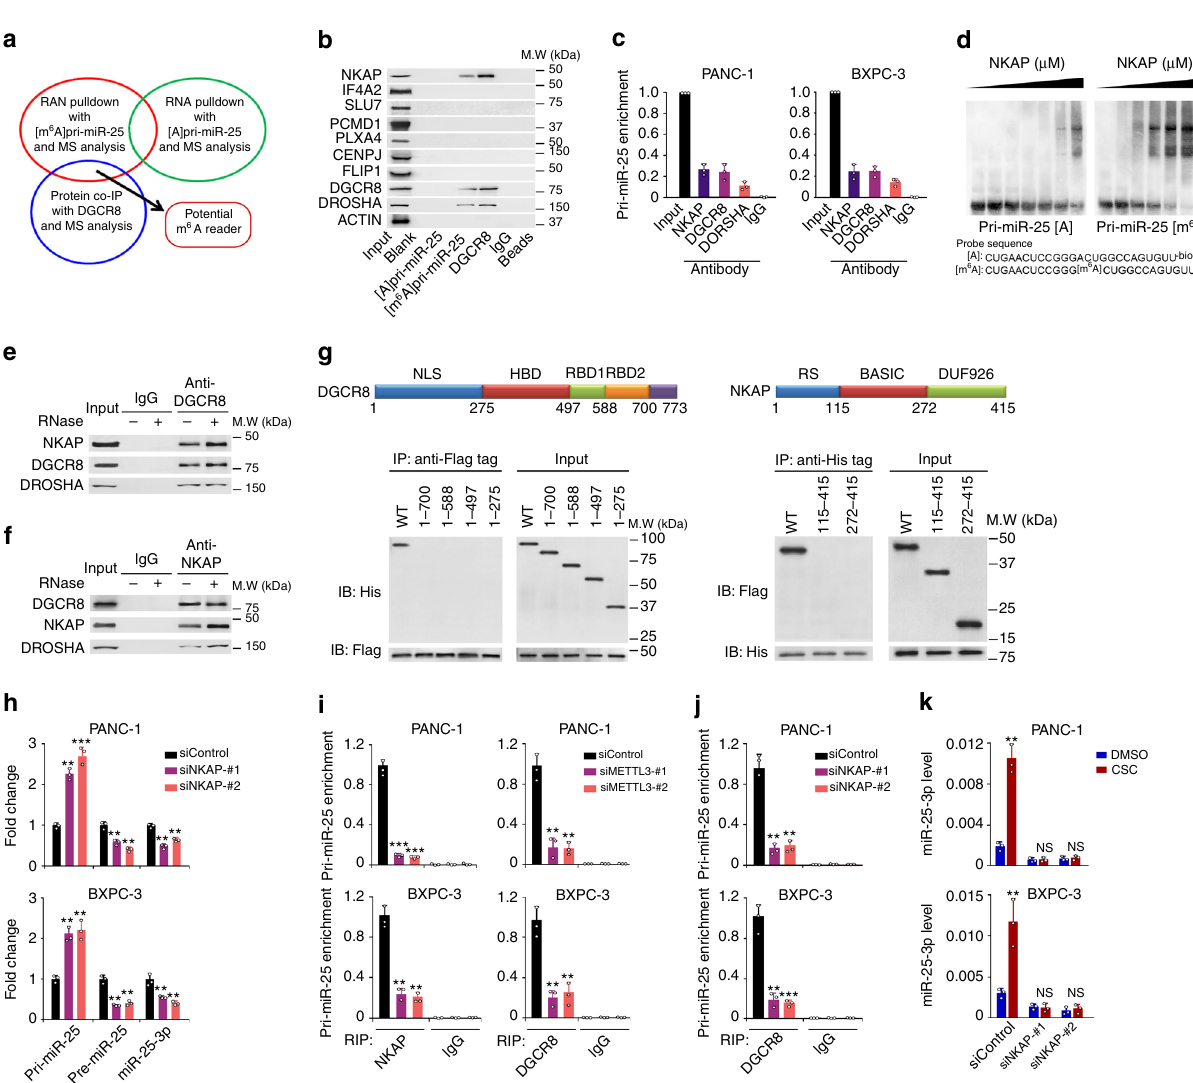
Fig. 4 Identi fi cation of NKAP as a mediator of m 6 A in pri-miR-25 maturation. a Schematic of RNA pulldown and immunoprecipitation experiment and proteomic screening by mass spectrometry (MS) for the identi fi cation of [m 6 A]pri-miR-25 reader. b Western blot analysis of potential m 6 A readers obtained from proteomic screening as indicated in ( a ) shows speci fi c association of NKAP with both [m 6 A]pri-miR-25 and DGCR8. c RNA immunoprecipitation assays with m 6 A antibody show association of NKAP (FLAG-tagged) with pri-miR-25 in PDAC cells. Data from three independent experiments represent RNA levels associated with NKAP relative to input. Antibody against DGCR8 or DROSHA was included as positive control and IgG served as negative control. d Electrophoretic mobility shift assays of recombinant NKAP with unmethylated or methylated pri-miR-25 probes. The probes were maintained constantly while a gradient of 0 – 10 μ M recombinant NKAP was added to the reactions. e , f Reciprocal immunoprecipitation assays show interaction among DGCR8, DROSHA, and NKAP (FLAG-tagged) in PANC-1 cells in the presence of RNase A. g Con fi rmation of binding of DGCR8 to NKAP by truncation mapping test. Upper panel shown are the schematic of the domain structures of DGCR8 and NKAP protein. Lower panel: Western blot analysis of constructs for His-tagged DGCR8 (wild-type versus domain truncation mutants) and FLAG-tagged NKAP or for FLAG-tagged NKAP (wild-type versus domain truncation mutants) and His-tagged DGCR8 that were co-transfected into PANC-1 cells, respectively. h Knockdown of NKAP expression in PDAC cells substantially decreased pre-miR-25 and miR-25-3p levels but substantially increased the level of pri-miR-25. i RNA immunoprecipitation assays show signi fi cantly decreased enrichment of pri-miR-25 with NKAP (left panel) or DGCR8 (right panel) in PDAC cells with METTL3 knockdown. j RNA immunoprecipitation assays show signi fi cantly decreased enrichment of pri-miR-25 with DGCR8 in PDAC cells with NKAP knockdown. k NKAP knockdown affected the expression of miR-25-3p in PDAC cells exposed to CSC. Values of ( h – k ) are the mean ± S.D. from three independent experiments. All statistic analyses in this fi gure are Student t test. * P < 0.05, ** P < 0.01, and *** P < 0.001 compared with the corresponding